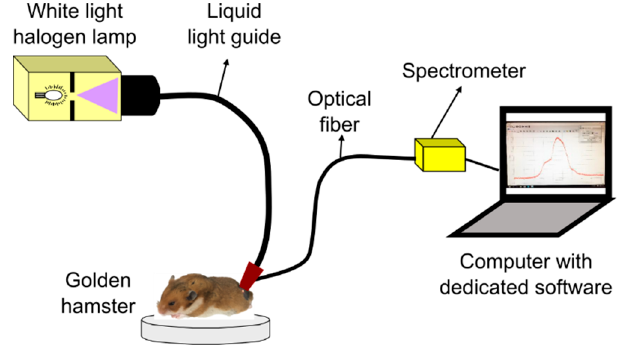
Figure 1. System for acquisition of diffuse reflectance spectra from healthy golden hamster skin.